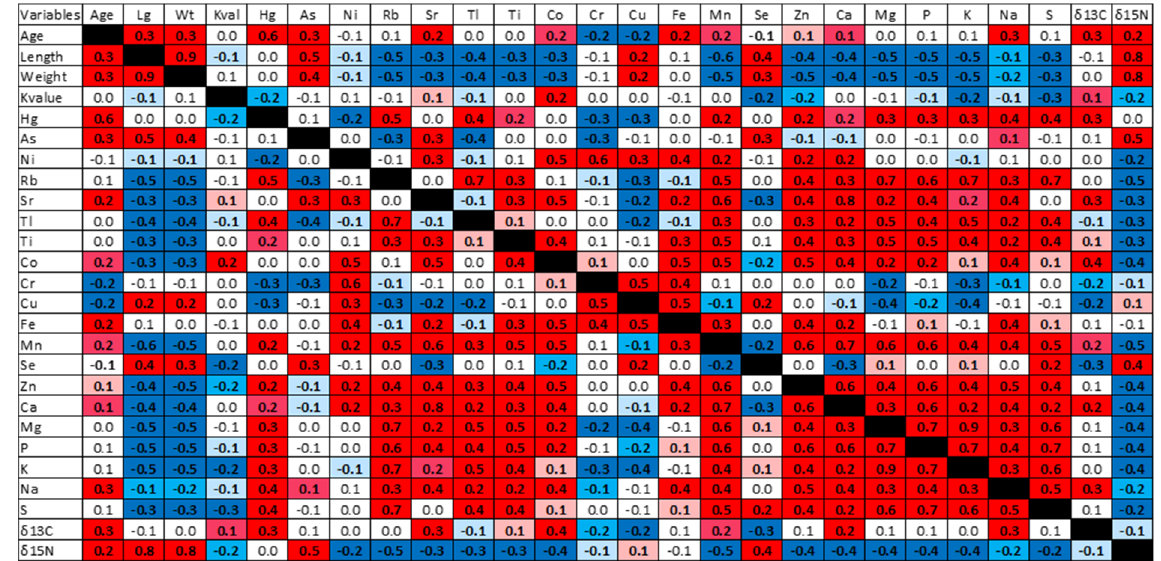
Figure 2. Spearman’s rank correlations were calculated between elements at sufficient concentrations to be detectable in >70% of salmonid samples (including THg), as well as age, as determined by otolith analysis, fork length (Lg), weight (Wt), condition (Kval), elements (as shown by their standard abbreviations), as well as levels of isotopes for carbon ( δ 13 C) and nitrogen ( δ 15 N). The correlation matrix (DF = 319) shows rho ( ρ ) values in cells. Statistically significant correlations are colored, with colors indicating p -values < 0.001 (red for positive correlations, dark blue for negative correlations), p between 0.001 and 0.01 (pink for positive, aqua for negative), and p between 0.01 and 0.05 (pale pink for positive, pale blue for negative).